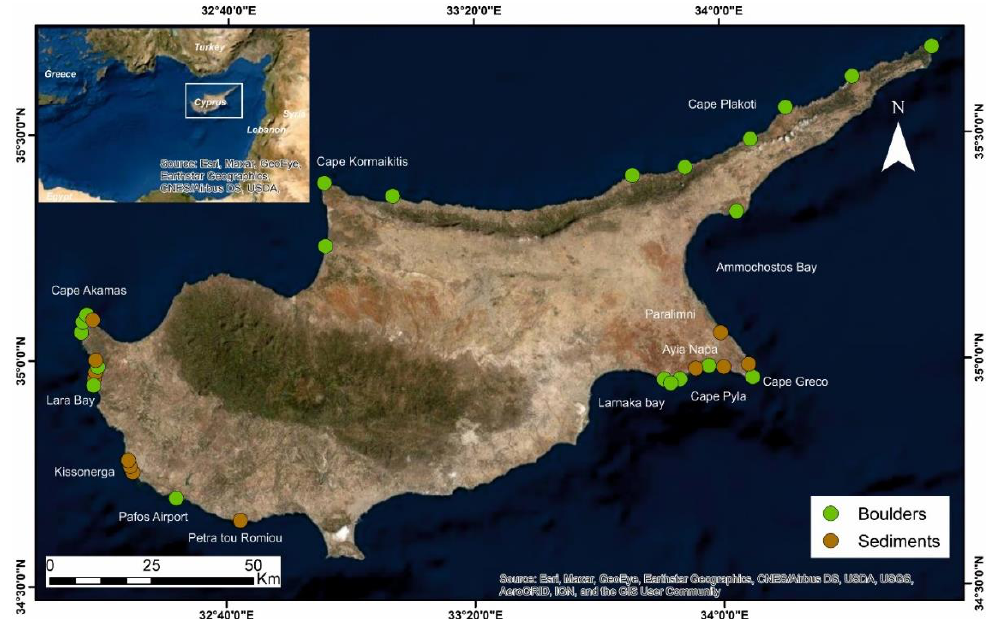
Figure 1. Geomorphological evidence of tsunamis around the coastal zone of Cyprus (data from [27–29]). At the southeastern part is Cape Greco, the study area. Base map sources: Esri, DigitalGlobe, GeoEye, i-cubed, USDA FSA, USGS, AEX, Getmapping, Aerogrid, IGN, IGP, swisstopo, and the GIS User Community.